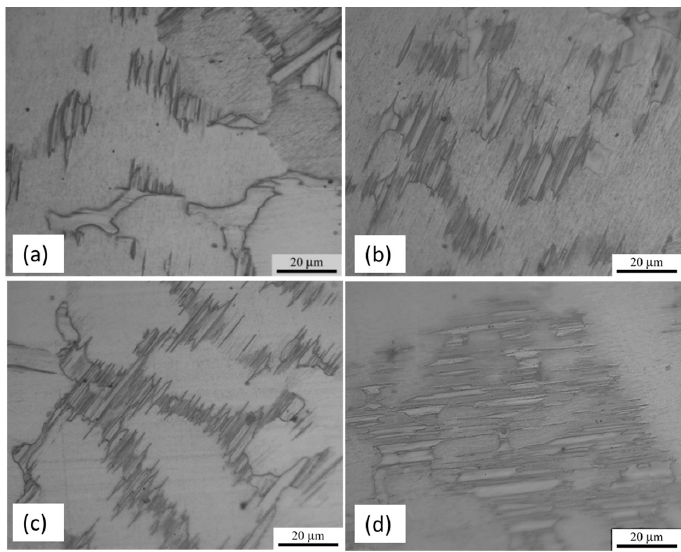
Figure 4. Optical micrographs of as-cast and solution-treated alloys taken at higher magnification showing the growth of secondary phase into the matrix after heat treatment. ( a ) MgZnY-C; ( b ) HA-C; ( c ) MgZnY-T; ( d ) HA-T alloys.